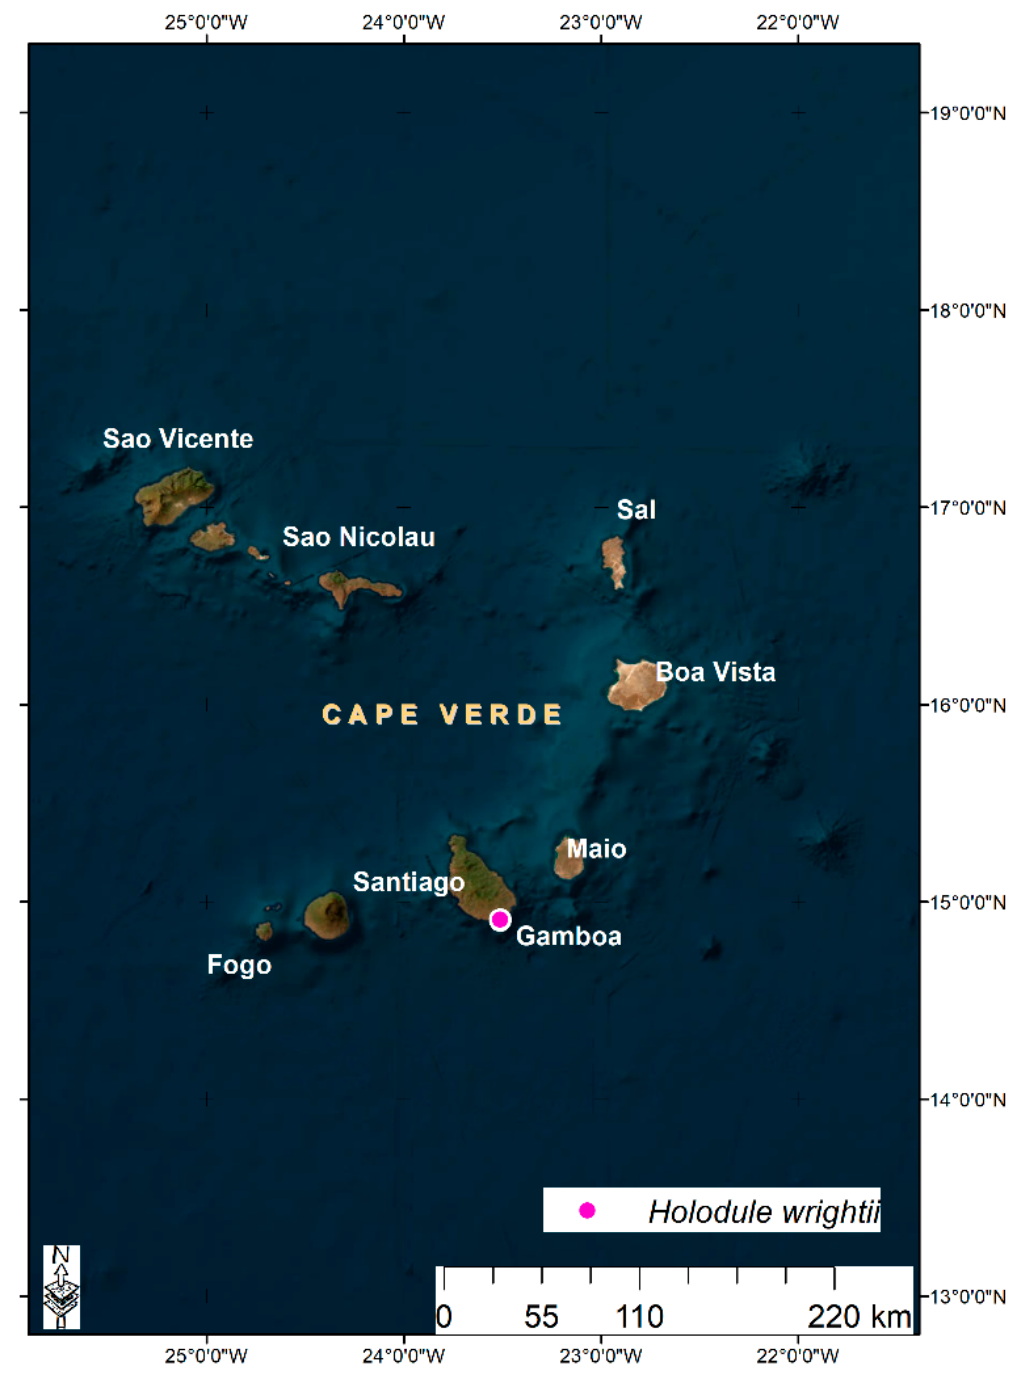
Figure 5. Seagrass distribution in Cabo Verde.